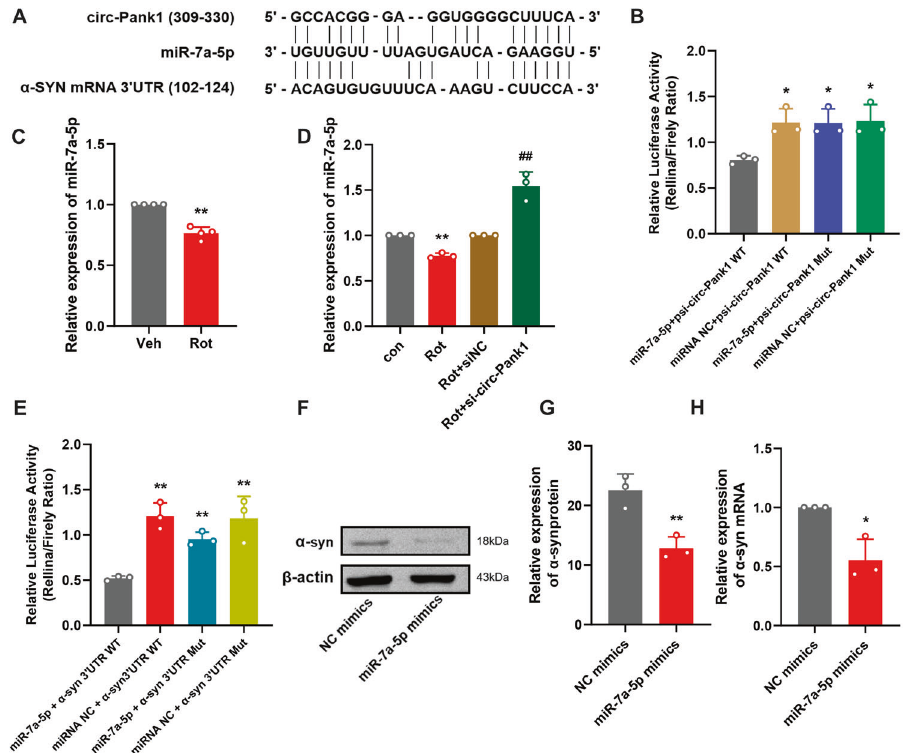
Fig. 4 Interaction between circ-Pank1/miR-7a-5p/a-syn in MN9D cells. A Schematic diagram of binding sites between circ-Pank1 and the α - syn mRNA 3 ’ UTR and miR-7a-5p. B The regulatory effect of circ-Pank1 on the expression of miR-7a-5p was veri fi ed by dual-luciferase reporter gene detection. The psi-circ-Pank-WT/Mut plasmid and miR-7a-5p mimic were cotransfected into HEK293T cells, and the luciferase activity was measured after 24 h ( n = 3). C qRT – PCR was used to detect the expression of miR-7a-5p in the SN of PD model mice treated with rotenone ( n = 4). D After si-circ-Pank1 and the corresponding control were transferred to the MN9D cell model treated with rotenone, the expression changes of miR-7a-5p were detected by qRT – PCR ( n = 3). E The regulatory effect of miR-7a-5p on α -syn expression was veri fi ed by the dual- luciferase reporter gene detection. The psi- α -syn WT/Mut plasmid and miR-7a-5p mimic were co-transfected into HEK293T cells. After 24 h, the luciferase activity was measured. F – H After the transfection of miR-7a-5p mimics in MN9D cells ( n = 3), Western blot analysis of α -syn protein levels F , G qRT – PCR detection of α -syn mRNA expression H . Data are presented as mean ± SD. * P < 0.05, ** P <